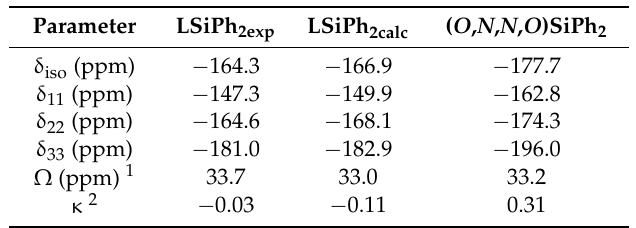
Figure 4. 29 Si CP/MAS NMR spinning side band spectrum of LSiPh 2 ( ν spin = 500 Hz) ( left ), and directions of the principal components δ 11 , δ 22 and δ 33 of the CSA tensor in the molecule ( right ). Table 3. Parameters of the 29 Si NMR CSA tensor (isotropic chemical shift δ iso ; principal components δ 11 , δ 22 , δ 33 ; span Ω ; skew κ , according to the Herzfeld–Berger notation [88,89]) for LSiPh 2 obtained from a CP/MAS spectrum (LSiPh 2exp ) and from quantum chemical calculations (LSiPh 2calc ) as well as experimentally obtained CSA tensor data of a hexacoordinate ( O , N , N , O )SiPh 2 complex of the chelating ligand shown in Scheme 1 for compound C .